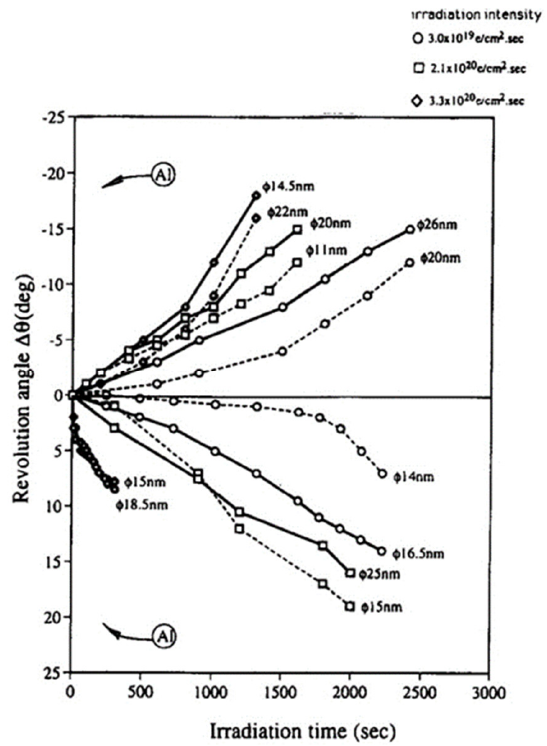
Figure 7. Rotation of Al nanodecahedra and its dependence on the irradiation intensity ranging from 3.0 × 10 19 to 3.3 × 10 20 e/cm 2 sec. The diameter of the nanoparticles is 20 nm, denoted on the line as  0 [6].